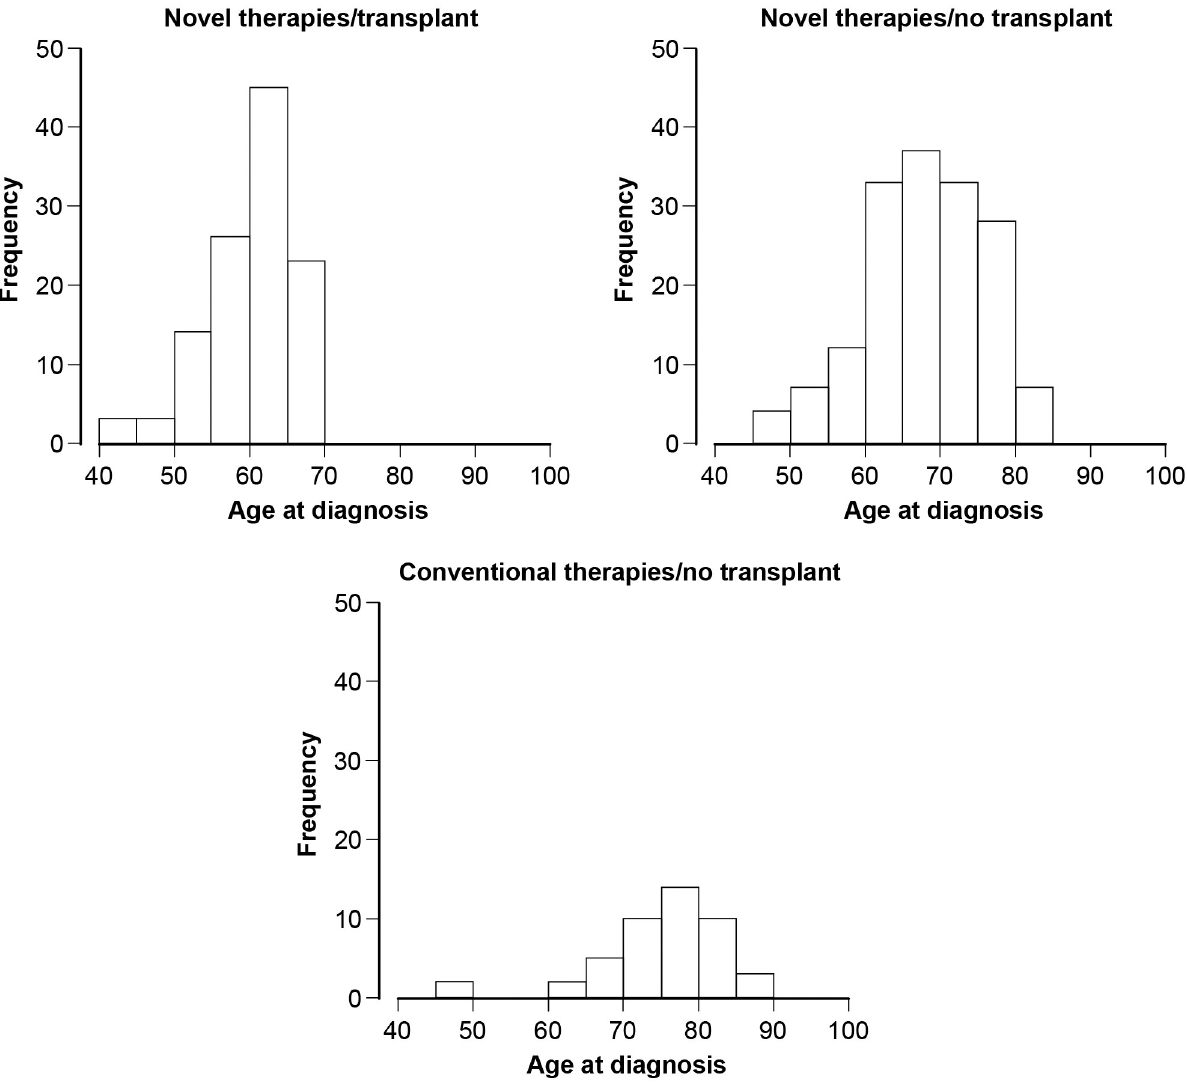
Fig 1. First-line treatment choice by age at